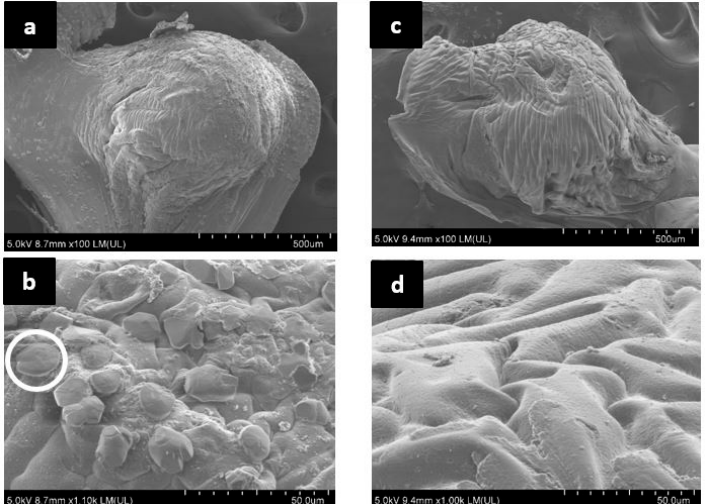
Figure 7. FE-SEM micrographs of S and NS1 capsules resuspended in CF for 7 days. ( a ) NS1 capsule after 7 days of resuspension in CF ×100 magnification ( b ) NS1 capsule after 7 days of resuspension in CF ×1000 magnification ( c ) S capsule after 7 days of resuspension in CF ×100 magnification ( d ) S capsule after 7 days of resuspension in CF ×1000 magnification.